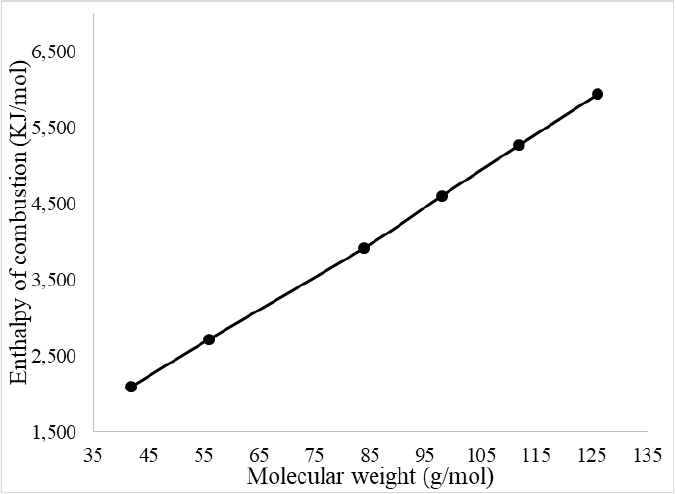
Figure 12. The effect of molecular weight of naphthenes on enthalpy of combustion .